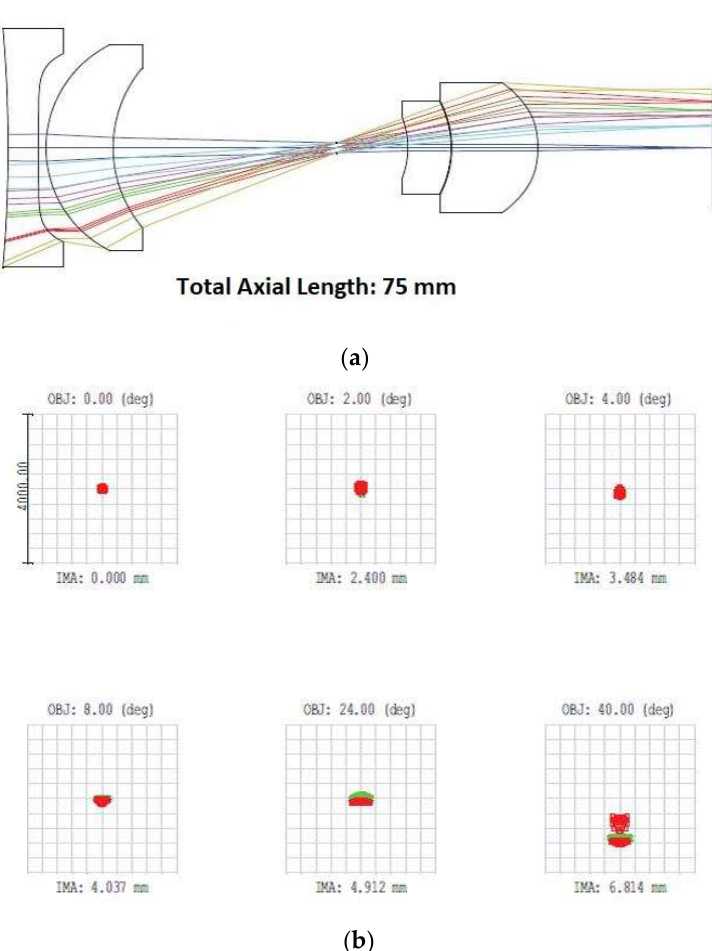
Figure 6. ( a ) Wide-angle foveated objective presented by Shimizu, et al. [32]; ( b ) Corresponding spot diagram for a number of field positions. Full scale on each subplot is 4 mm.